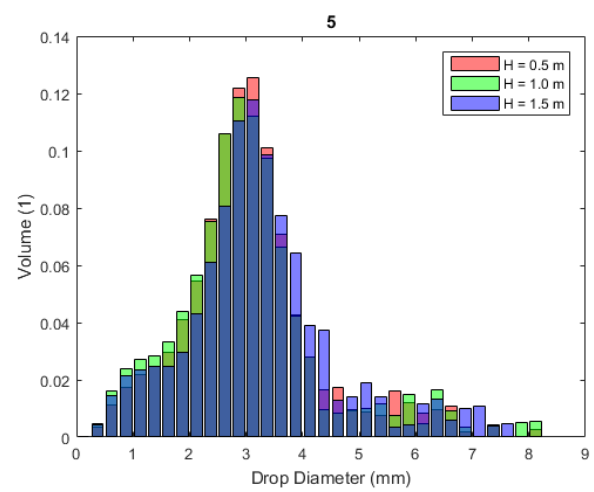
Fig. 13. Drop size histogram based on volume for the mean water flow rate 0.0003880 m 3 /s